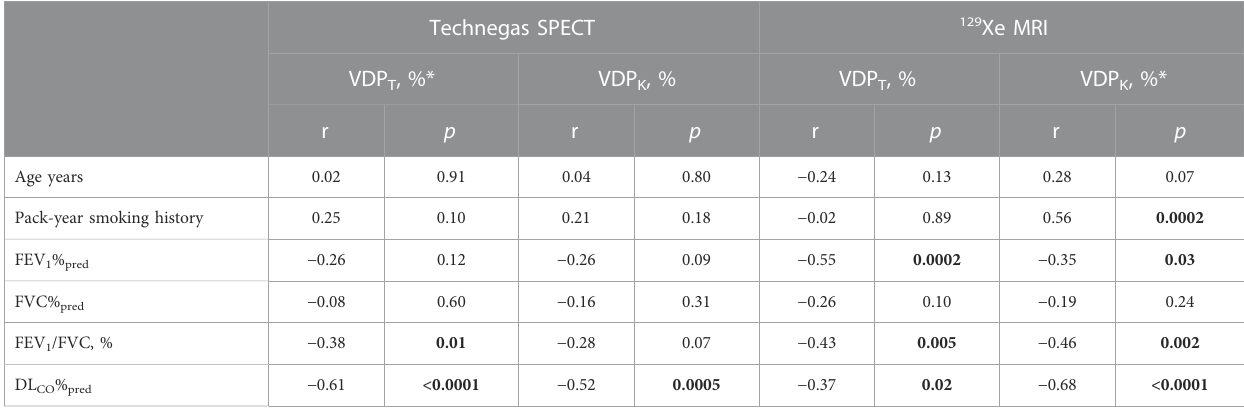
TABLE 2 Univariate relationships of Technegas SPECT VDP and 129 Xe MRI VDP with participant demographics and clinical characteristics. Technegas